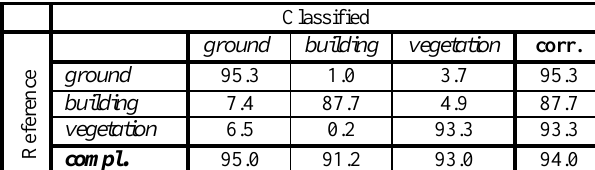
Table 4: Confusions matrix [%] with completeness (comp.) and correctness (corr.)